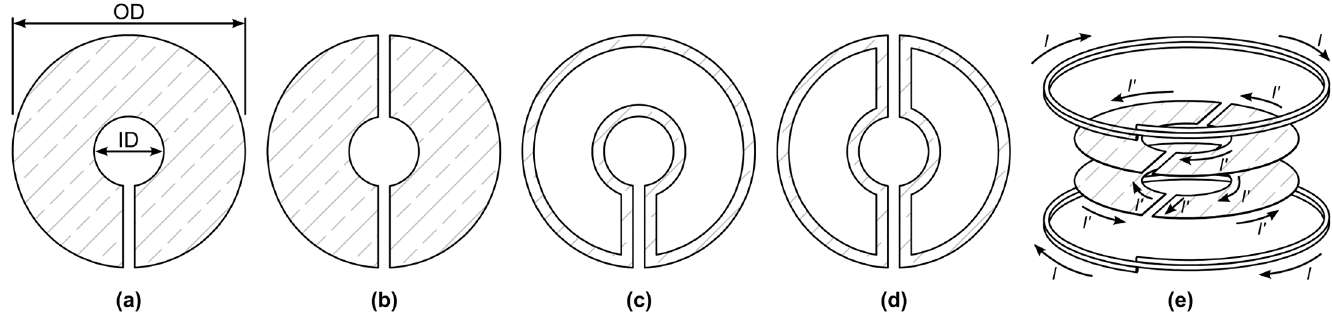
Fig 1. The four basic designs of Lenz lenses. They are either made from solid metal (subfigures (a) and (b)) or wire material(sub-figures(c) and (d)), arrangedsymmetrically ((b) and (d)) or non-symmetrically ((a) and (c)). The slit(s) guide inducedcurrent I 0 from the outer edge to the inner edge, while reversingthe flow direction, as further depictedin (e), where two lenses are arrangedin parallelin a Helmholtzpair like configuration, denotedas a double Lenz lens configuration.